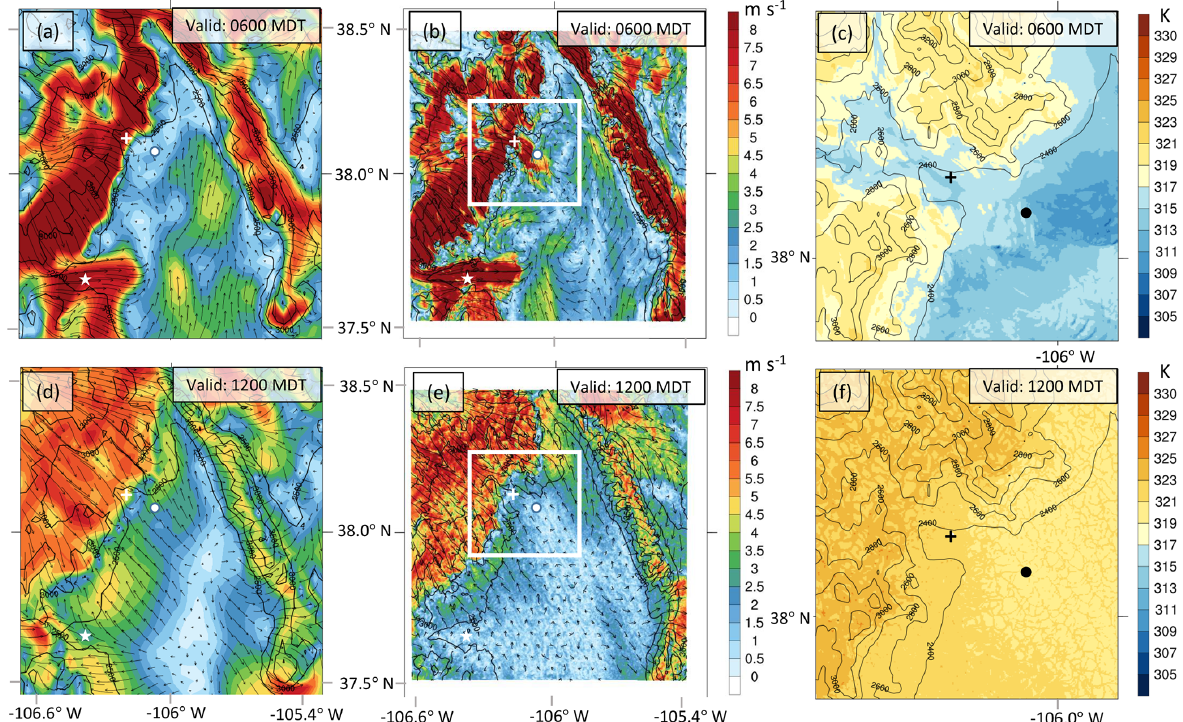
Figure 5. Wind speed (colors) and direction (arrows) at 80ma.g.l. from (a) HRRR (issued at 22:00MDT on previous day) and (b) WRF LES and (c) WRF LES potential temperature at 80ma.g.l. for zoomed-in region denoted by the white box in panel (b) for forecasts valid at 06:00 and 12:00MDT on 19 July 2018. Model terrain heights are denoted by black contours. Symbols denote locations as follows: asterisk – Saguache; star – Del Norte; filled circle – NSSL sounding